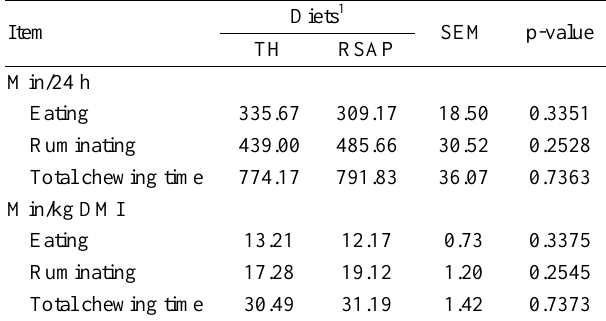
Table 4. Chewing activity of cows fed experimental